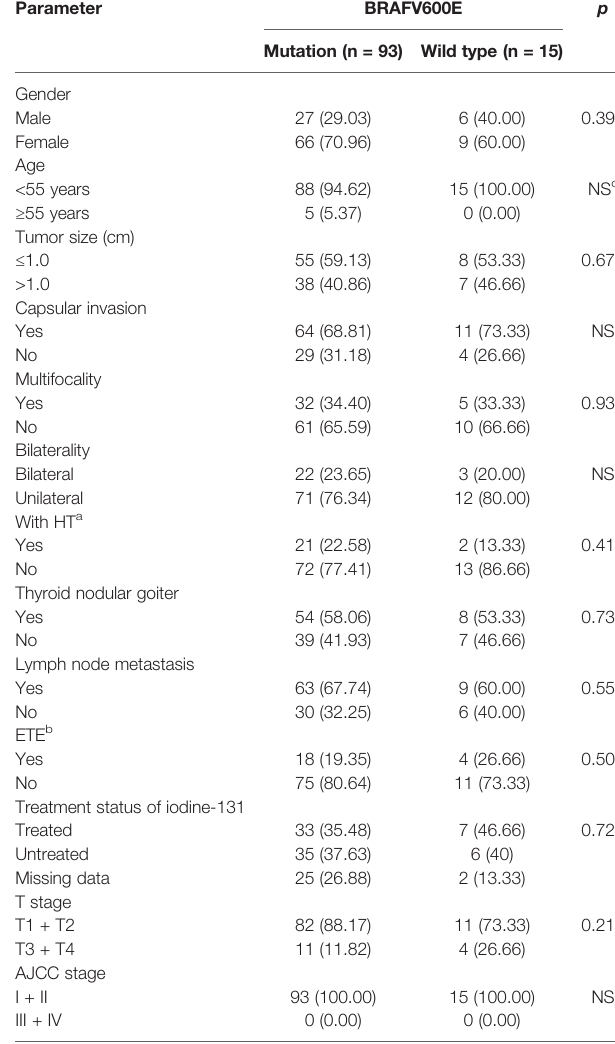
TABLE 7 | Relationship of BRAF V600E with clinicopathological factors of FNMTC, n (%). Parameter BRAF V600E p Mutation (n = 39) Wild type (n = 10)